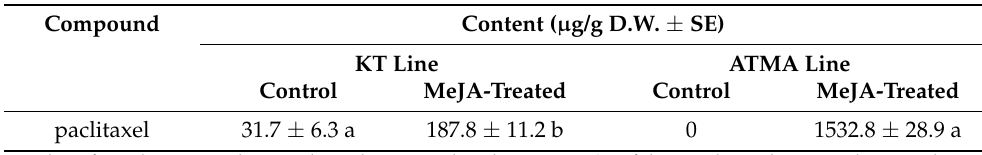
Table 5. The content of paclitaxel in the T. × media KT and ATMA hairy root lines after elicitation with 100 µ M